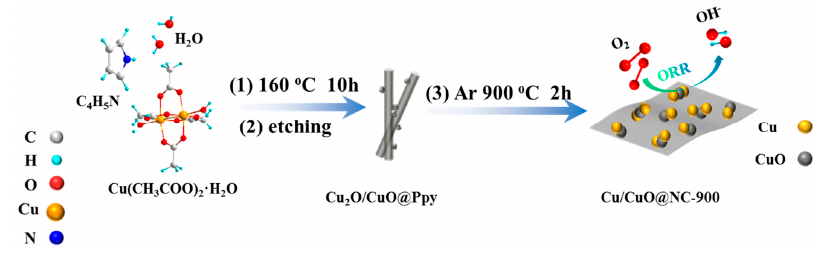
Figure 1. Schematic illustration for the synthesis process of Cu/CuO@NC-900. The phase compositions of the as-synthesized samples were characterized by a pow- der X-ray diffractometer (XRD). In the XRD pattern of Cu/CuO@NC-900 in Figure 2a, the corresponding peaks of the monoclinic CuO (NO. 80-1916), cubic Cu (NO. 85-1326), and C can be observed. The characteristic peaks of CuO appear at 32.48°, 35.49°, 38.68°, and 48.66°, corresponding to (110), ( − 111), (111), and ( − 202) crystal planes, respectively. To ob- vious diffraction peaks of (111), (200), and (220), the plane diffraction of Cu are located at 43.32°, 50.45°, and 74.12°, respectively. Meanwhile, the diffraction peak appearing at ~26° can be attributed to the (002) crystal plane of graphitic carbon [39]. These results indicate that Cu/CuO@NC-900 was composed of Cu, CuO, and carbon. In addition, the sizes of the sample Cu and CuO crystals were calculated by using Scherrer’s formula as shown in Tables S1 and S2. The data in the tables show that the particle size of Cu/CuO@NC-900 for CuO (12.781 nm) was smaller than that of Cu (59.394 nm). The XRD pattern of the samples treated with different heat treatment temperatures showed that the diffraction peaks of Cu/CuO@NC-800 and Cu/CuO@NC-1000 were similar to those of Cu/CuO@NC-900 and no new phases were generated, illustrating that the temperature had no effect on the phase composition of the samples (Figure S4). The Raman spectra of the synthesized samples were illustrated in Figure 2b and S5, where the peaks near 1340 and 1580 cm − 1 corre- sponded to the D and G bands of the carbon structure, respectively. Notably, the D band was related to the degree of disorder of the carbon at the sp 2 -hybridization, whereas the G band represented the degree of graphitization [40]. The D/G intensity ratio (I D /I G ) of